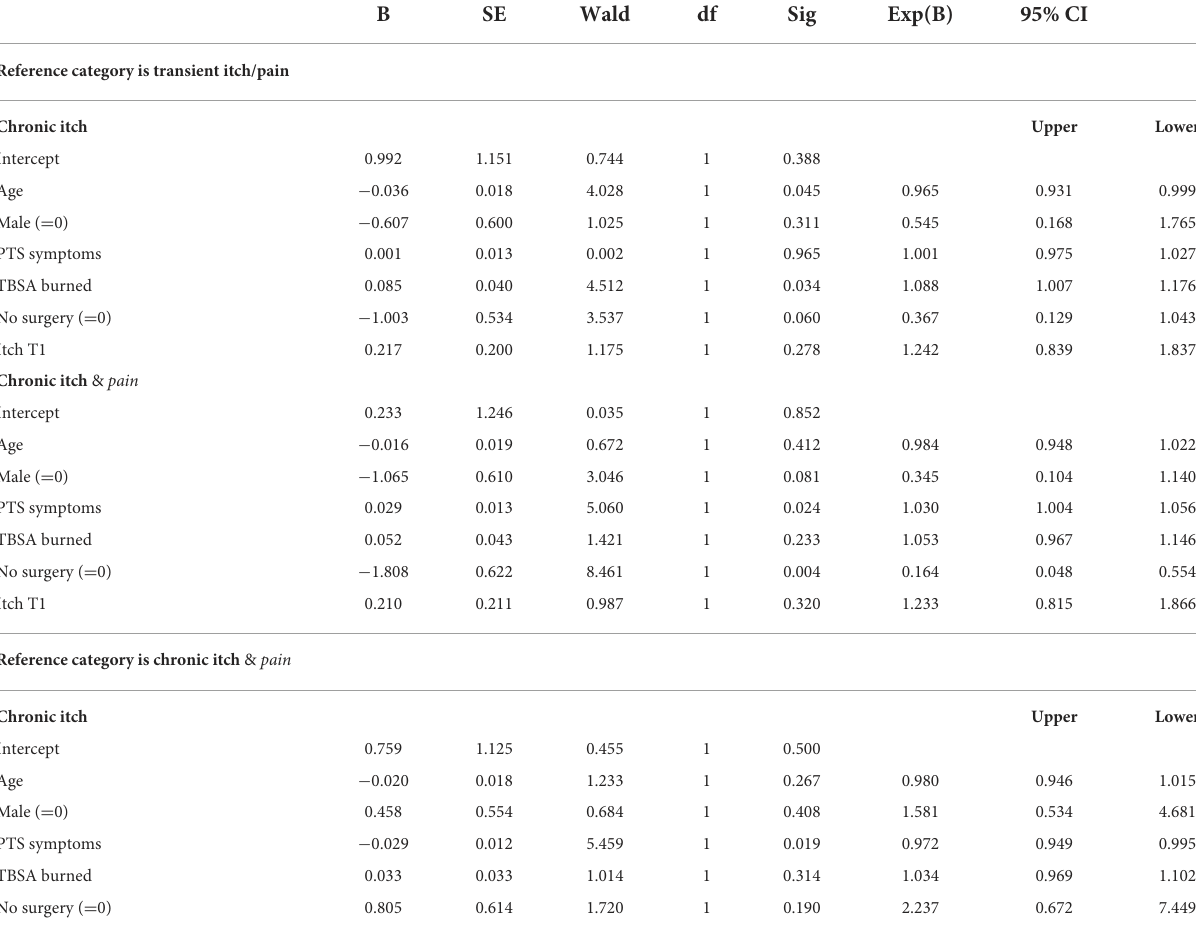
TABLE 2 Burn characteristics and demographics tested with multi-nominal regression analysis to predict classification into one of the three itch profiles.